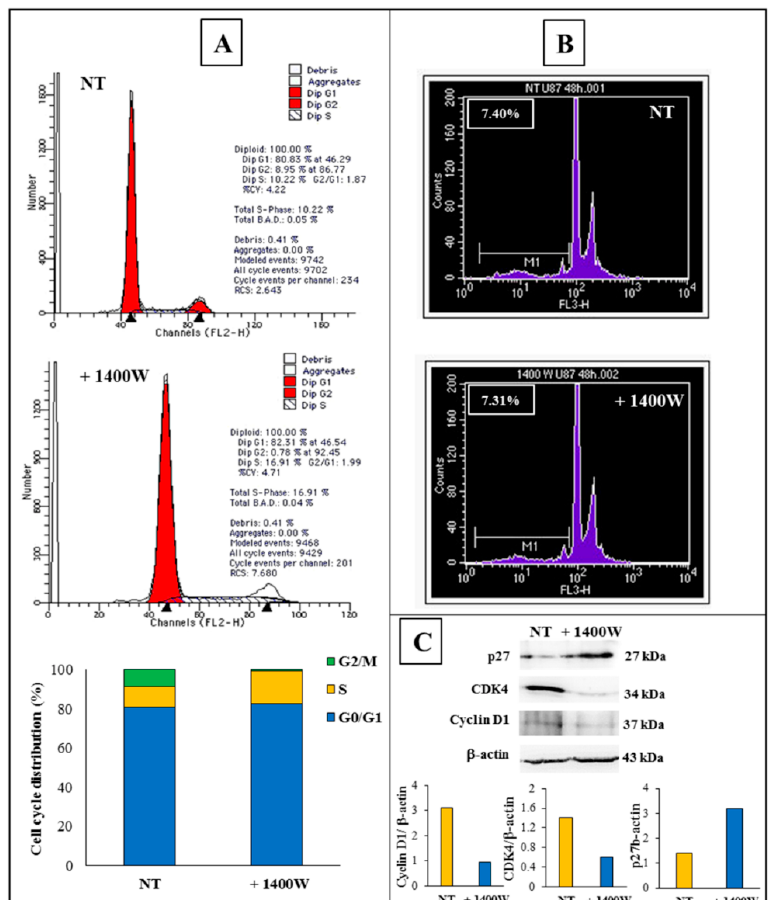
Figure 3. E ff ects of 1400W on U87MG-derived NS cell cycle. ( A ) Cell cycle profiles of NS-forming cells after 48 h incubation without (NT) or with 1400W (100 µ M). Cell cycle distribution (%) is also reported in the histogram. Results are representative of three independent experiments. ( B ) Flow cytometric profiles of apoptosis level analysis in NS-forming cells after 48 h incubation without (NT) or with 100 µ M 1400W. Results are representative of three independent experiment. ( C ) Representative images of western blot analysis of cell cycle-related proteins Cyclin D1, CDK4, and p27 in extracts of NS after 48 h incubation without (NT) or with 1400W (100 µ M). The results of densitometric analysis of bands expressed as ratio vs. β -actin band intensity are reported in the histograms. Data are representative